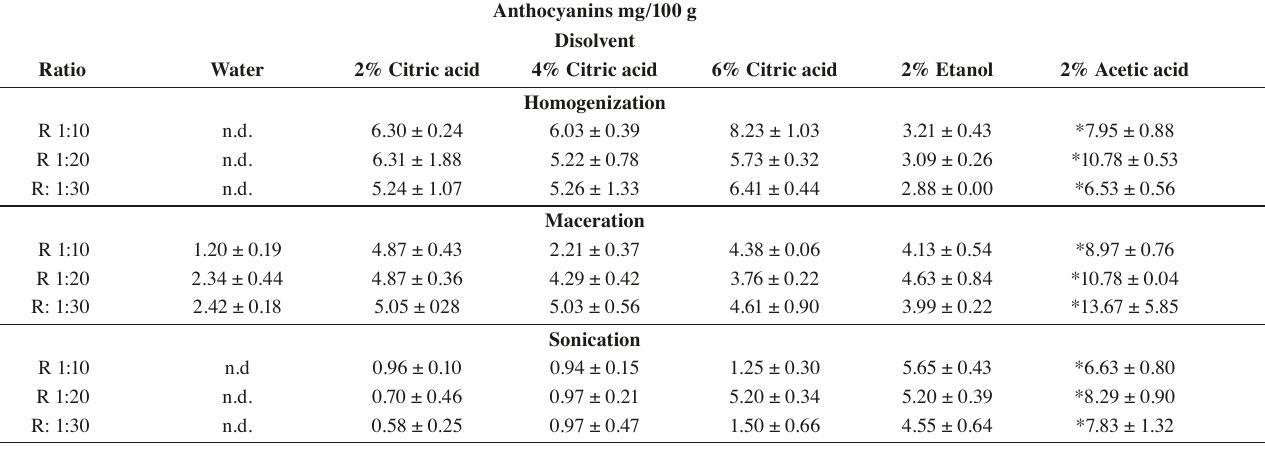
The * symbol indicates significant differences (p <0.05)